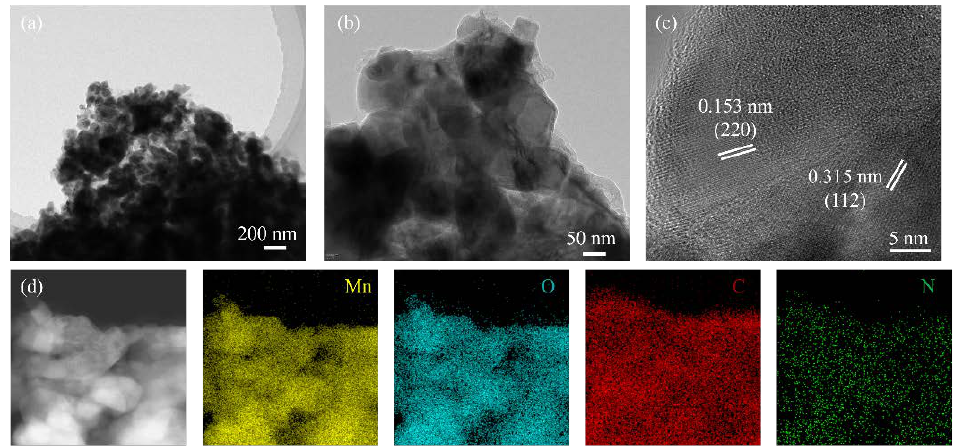
Figure 4. ( a , b ) TEM images of the MnO x @C-N samples. ( c ) HRTEM image of MnO x @C-N. ( d ) STEM image and corresponding element mapping (scale bar: 100 nm).